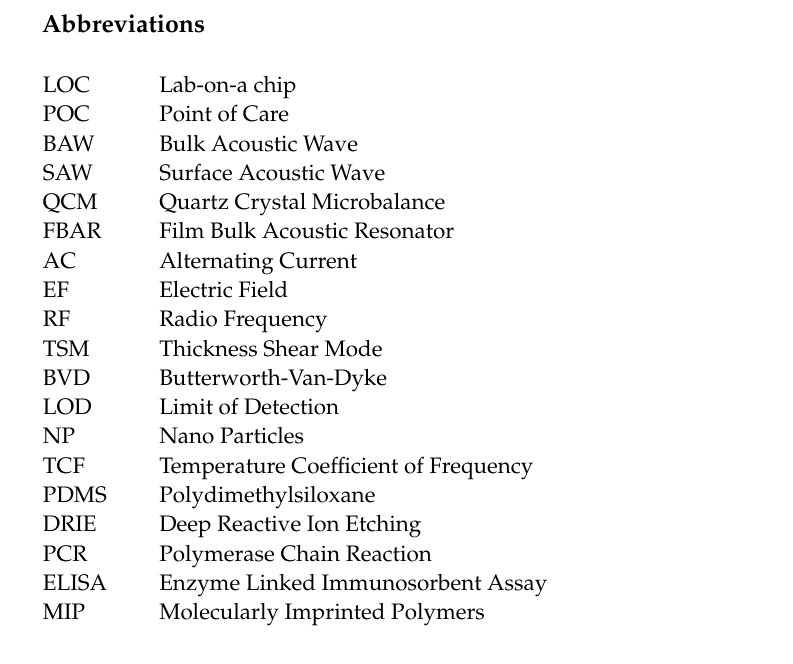
ceptors and performance indicator, Table S3: SAW biosensor applications with the corresponding bioreceptors and performance